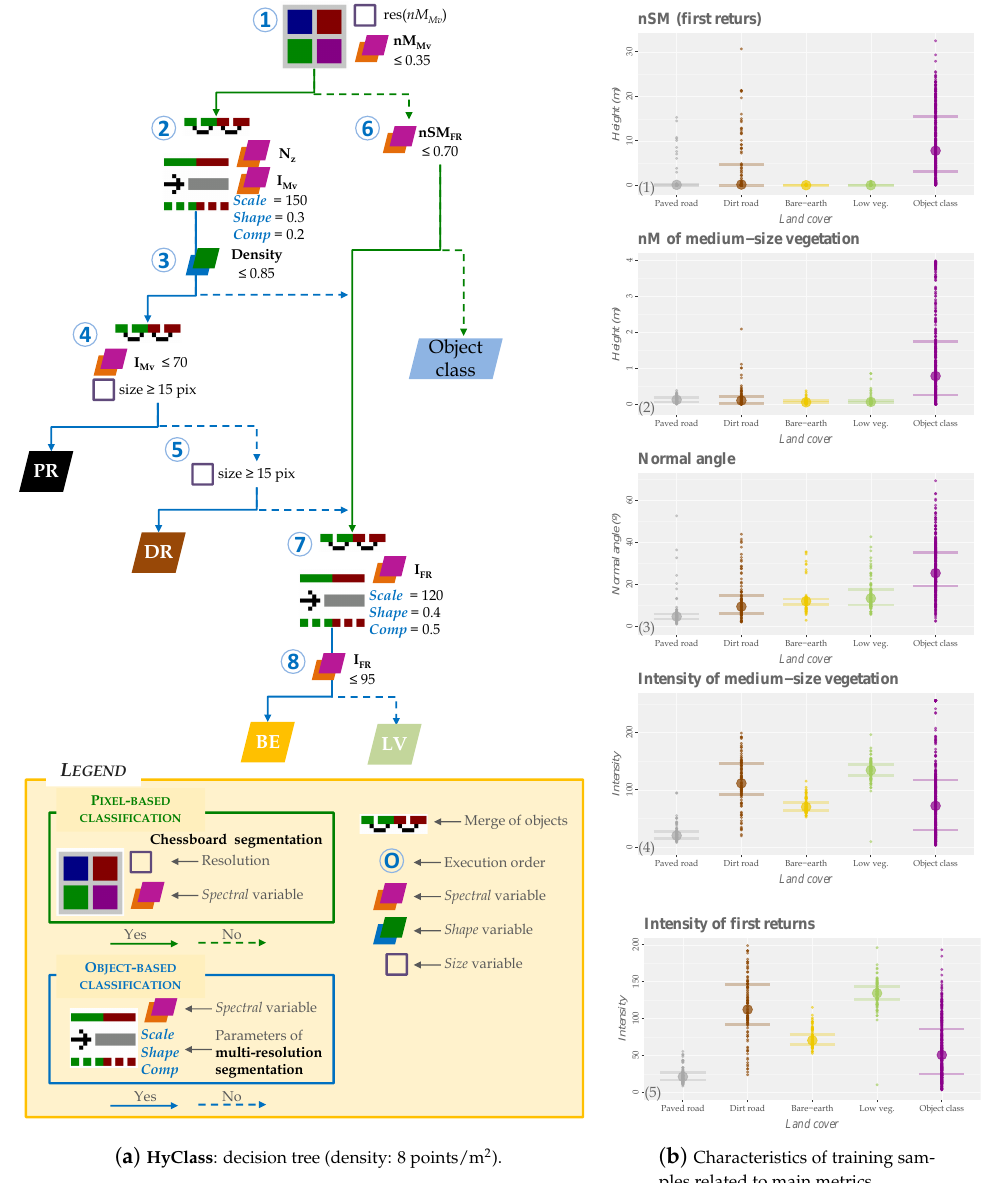
Figure 5. Decision tree and values of training samples for a high-density point cloud (8 points/m 2